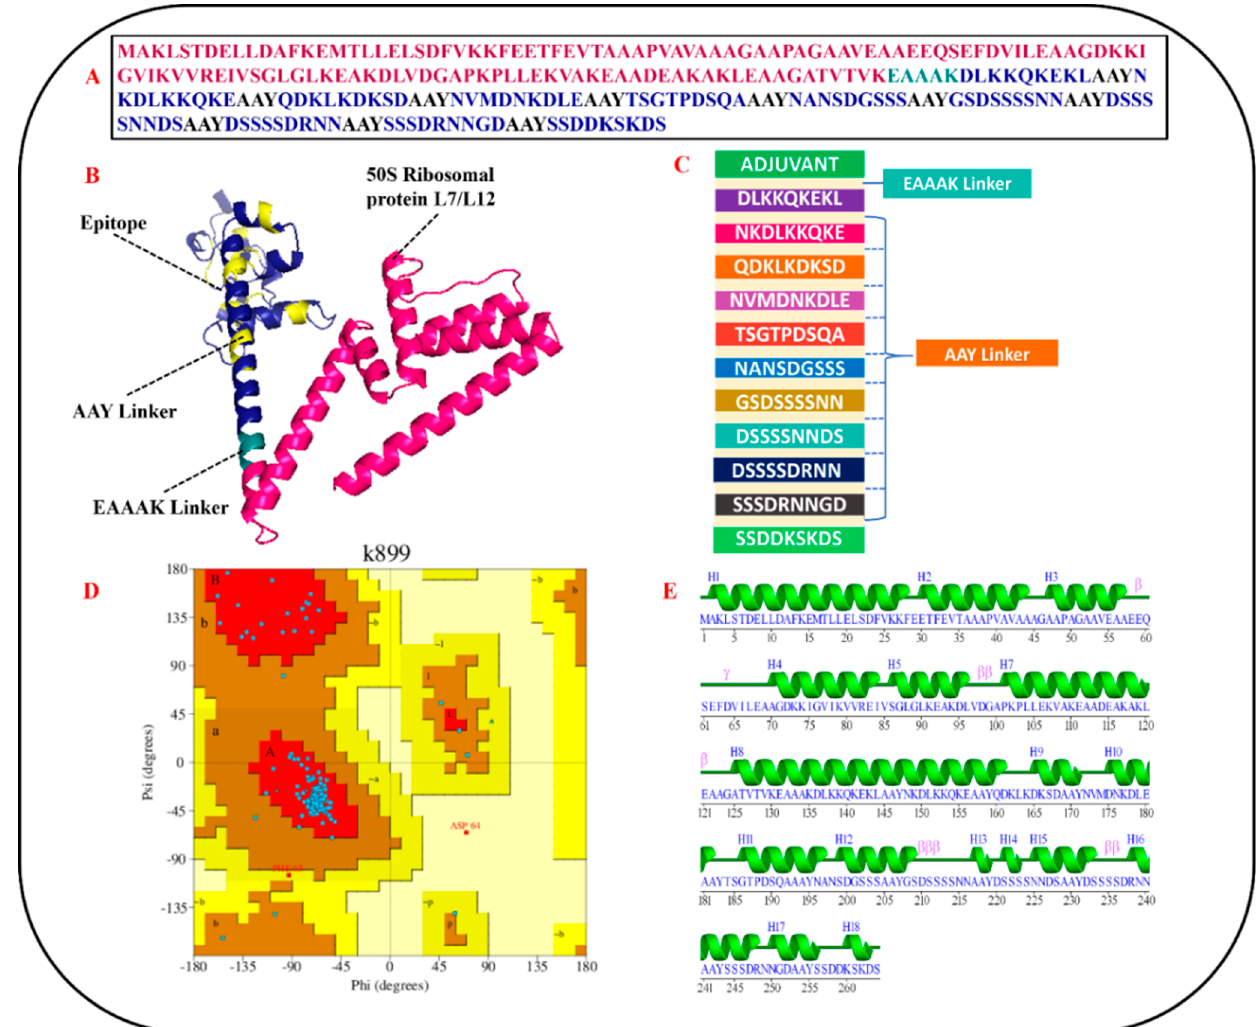
Figure 5. Schematic illustration of finalized MEV construct: ( A ) primary sequence of MEV construct; ( B ) predicted and refined 3D structure of MEV (50S ribosomal protein L7/L12 in hot − pink color, EAAAK linker in deep − teal shade, AAY linkers in yellow, and epitopes in dense − blue color); ( C ) graphical illustration of the arrangement of shortlisted epitopes, linkers, and adjuvant in designed MEV construct; ( D ) Ramachandran plot of refined MEV construct; ( E ) secondary structure details of MEV construct. Table 2. Description of refined MEV models generated by GalaxyRefine2.